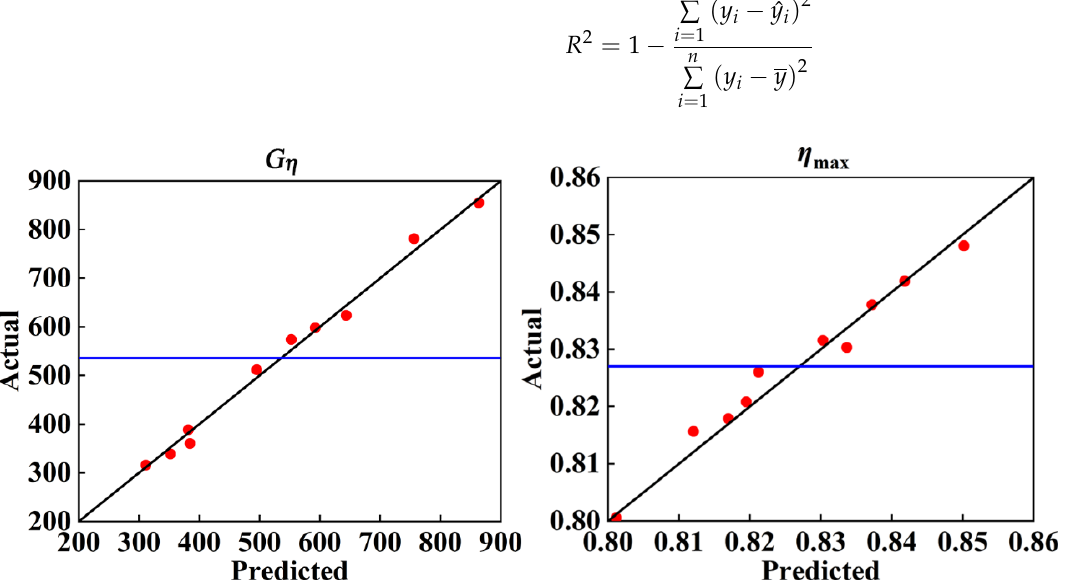
Figure 11. Precision measurement distribution of sample points. ( R 2 : G η = 0.99136; η max = 0.96857).